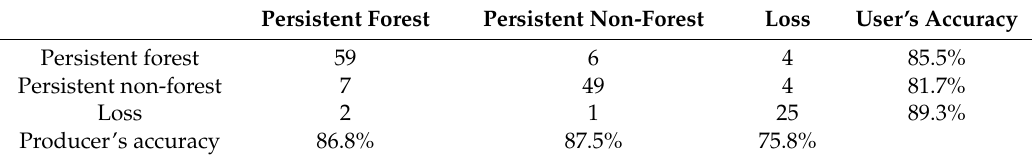
Table 4. Forest change validation; 2007–2014. Validation was done using annual NDVI forest change dataset derived from points visually interpreted using Landsat and high-resolution imagery. If areas classified as forest in 2007 showed decreases in NDVI values during adjacent year periods afterwards (e.g., between 2008 and 2009, 2010 and 2011, and so on through 2014), then the change areas were classed as forest loss. Areas that did not show changes in the forested or non-forested areas were classed as persistent forest or persistent non-forest. Overall accuracy using this approach was 84.7%. Persistent Forest Persistent Non-Forest Loss User’s Accuracy Persistent forest 59 85.5% 81.7%